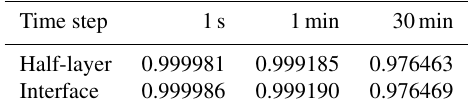
Table 1. Normalised standard deviation (SD) of Q S for high- resolution (1mm deep) simulations: aTEB wall test